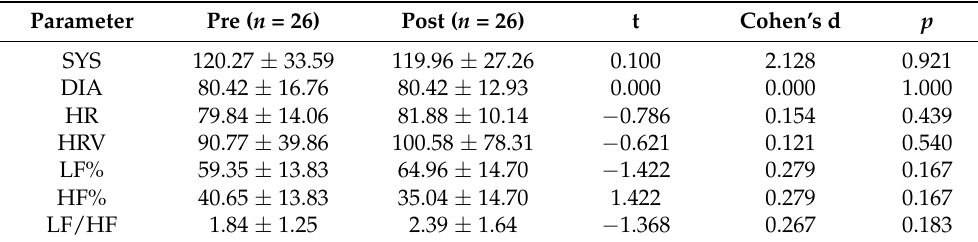
Table 3. Pre-post HRV indicators of paired t-test results for all